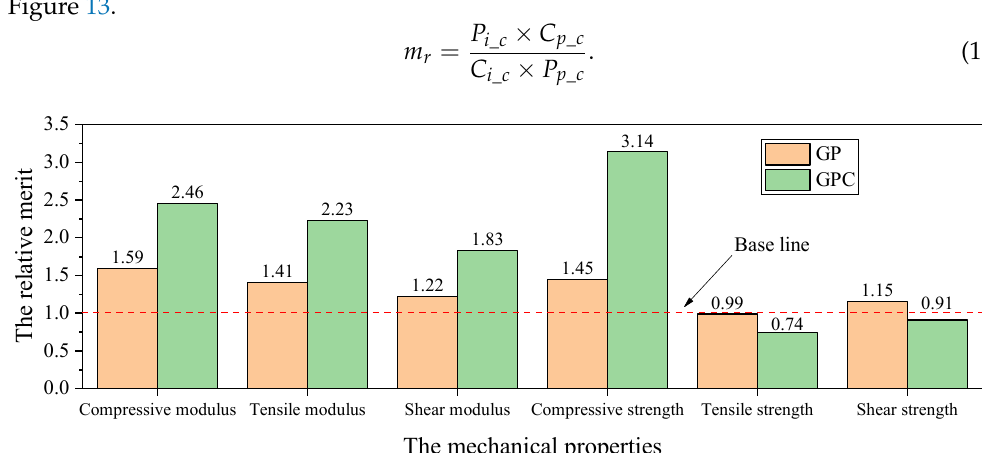
Figure 13. The relative merit corresponding to mechanical properties.